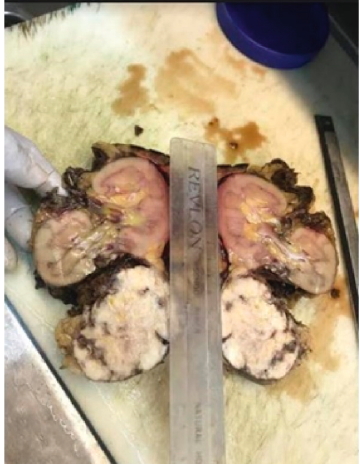
Figure 5: Gross anatomy specimen showing the exophytic renal cortical tumor incontinuity with the renal cortex (black arrow).